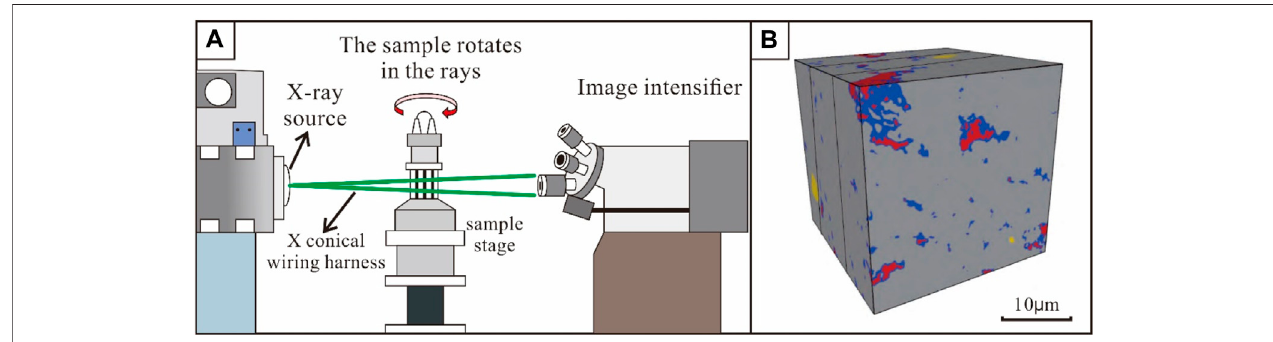
FIGURE 10 | Basic work principle of micro-computed tomography (CT). (A) Experimental principle; (B) 3D reconstruction of shale cores under CT (Gou et al., 2019).